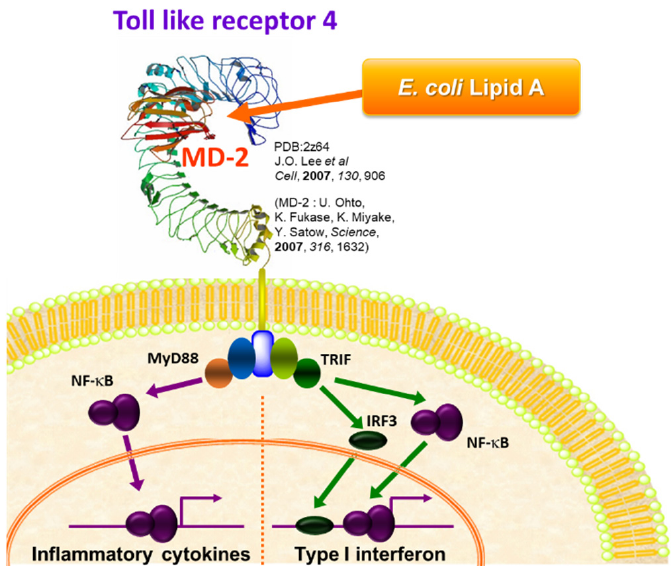
Figure 4. Innate immune activation via TLR4/MD2.